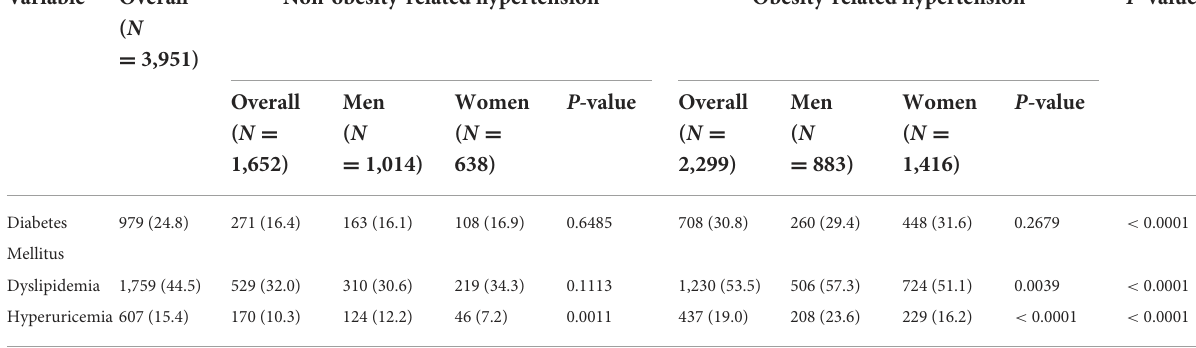
TABLE 6 Comorbidities in the obesity-related hypertensive and non-obesity-related hypertensive patients. Variable